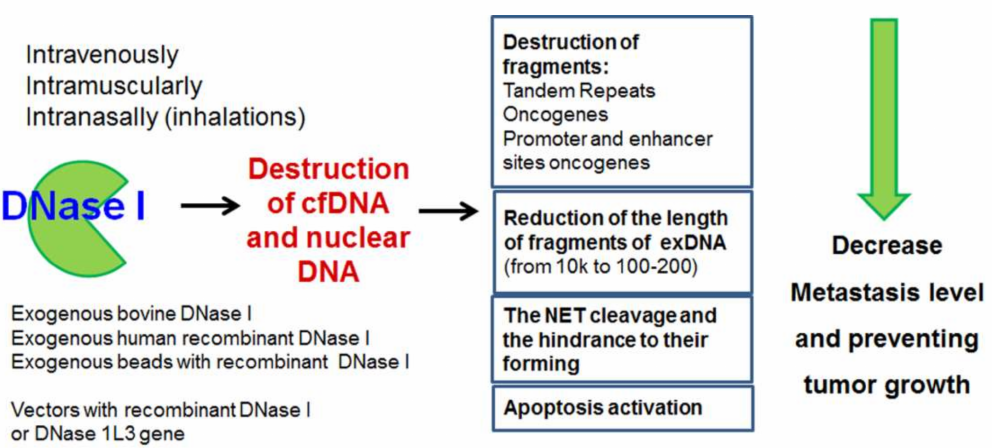
Figure 3. Possible use of DNases as therapeutic agents. Abbreviation: NET, neutrophil extracellular